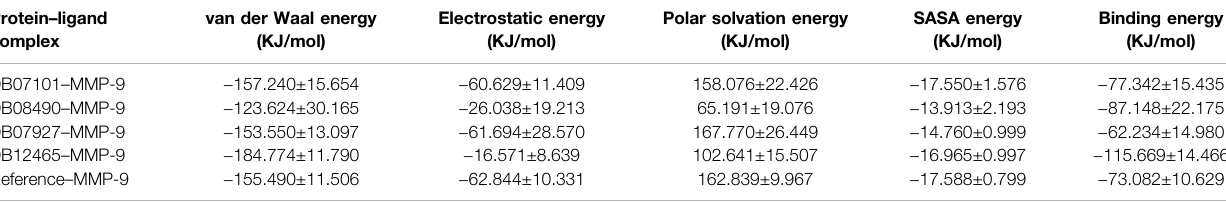
TABLE 4 | Table representing the van der Waal, electrostatic, polar salvation, SASA, and binding energy for protein – ligand complexes. Protein – ligand van der Waal energy Electrostatic energy Polar solvation energy complex (KJ/mol) (KJ/mol)